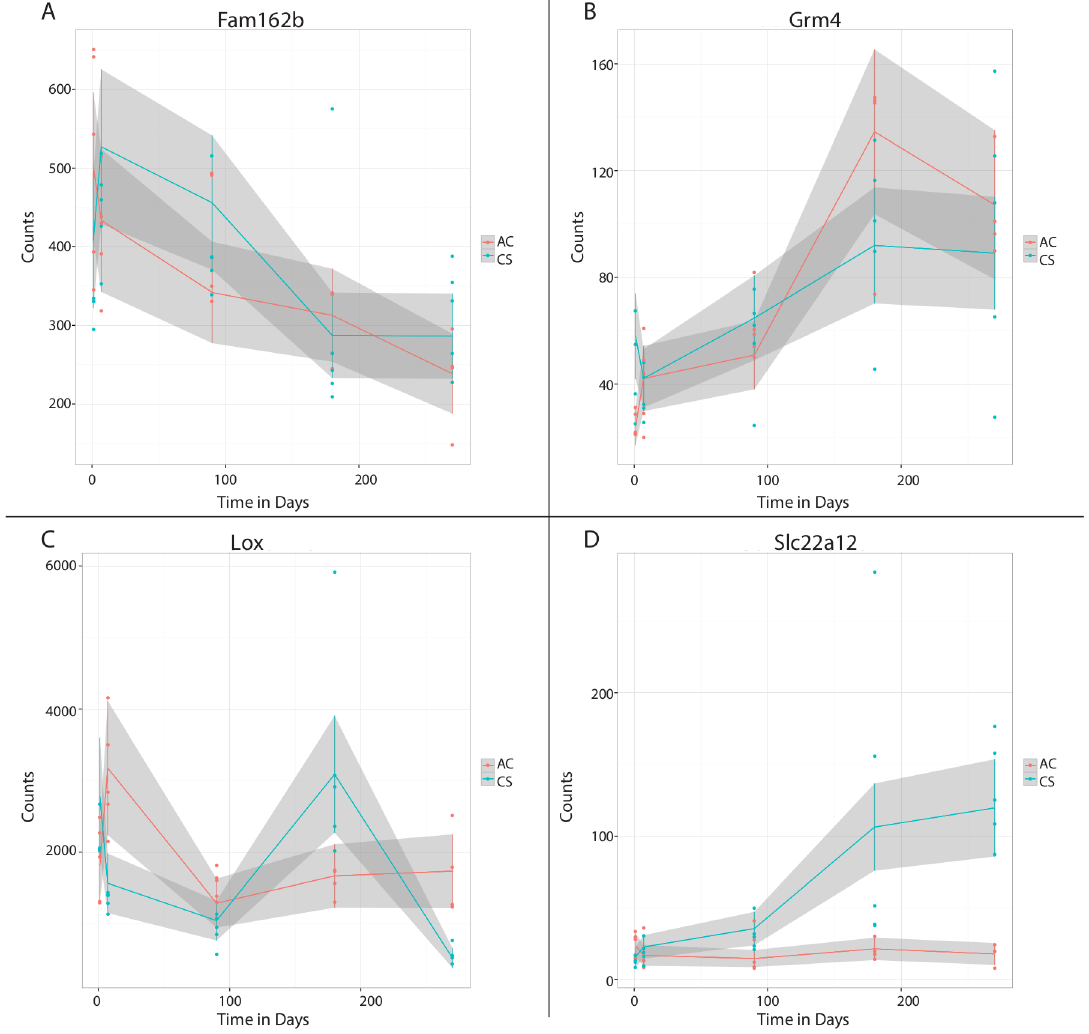
Fig 5. Genes showing a previously unsuspected significant time trend with CS exposure. (A) Fam162b shows a significantdownwardtrend for linear time and significant effect of group. (B) Grm4 shows significantupward trend for linear time and significanteffect of group. (C) Lox was bi-directionally regulatedin individualtime point analysis. (D) Slc22a12 displayedsignificantlinear time by treatment interaction, with no change in expressionin the AC group.